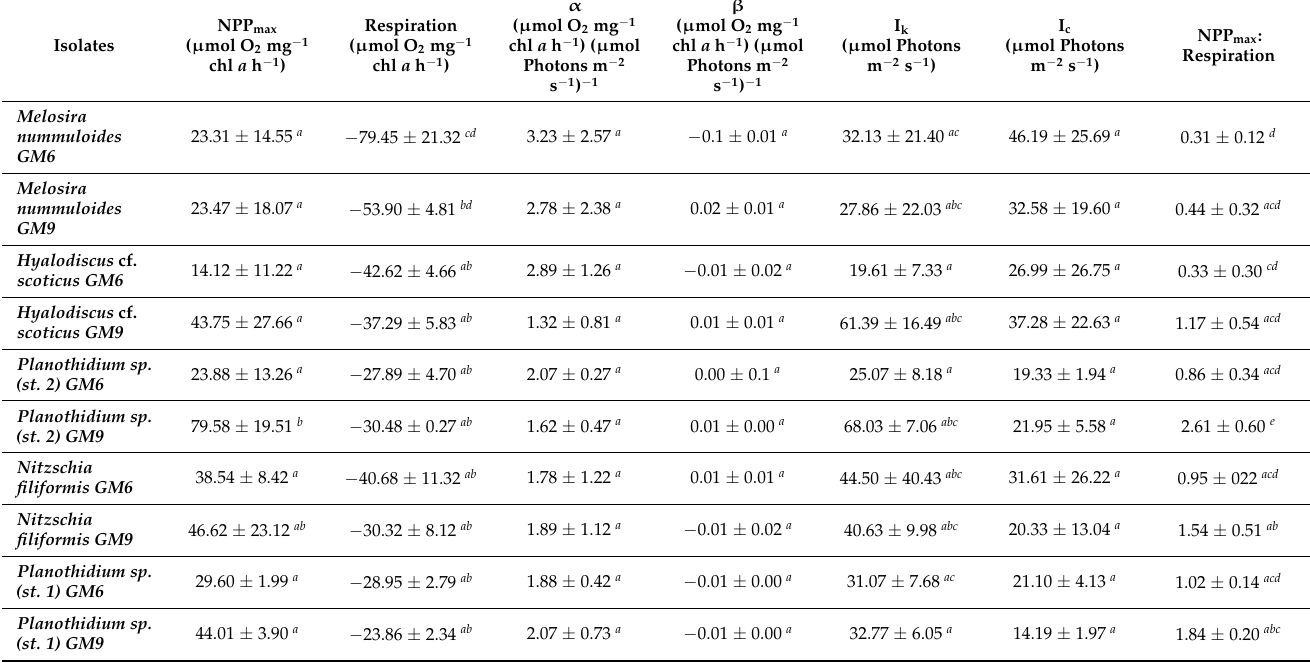
Table 2. Parameter of respective PI-curves (Figure 3A–D and Figure 4A–F) for five benthic diatom strains (n = 3) kept at 20 ◦ C in GM6 and GM9 media. Data represent mean values ± standard deviation (n = 3, except Melosira nummuloides GM6 n = 4, Hyalodiscus cf. scoticus GM6 n = 2). Different lowercase letters represent significant levels among all means as calculated by a one-way ANOVA (Tukey’s test, p < 0.05). NPP max represents the maximal oxygen production rate, alpha the initial slope of production in the light limited range, beta the terminal slope of production in extensive light range (photoinhibition), I k the light saturation point, and I c the light compensation